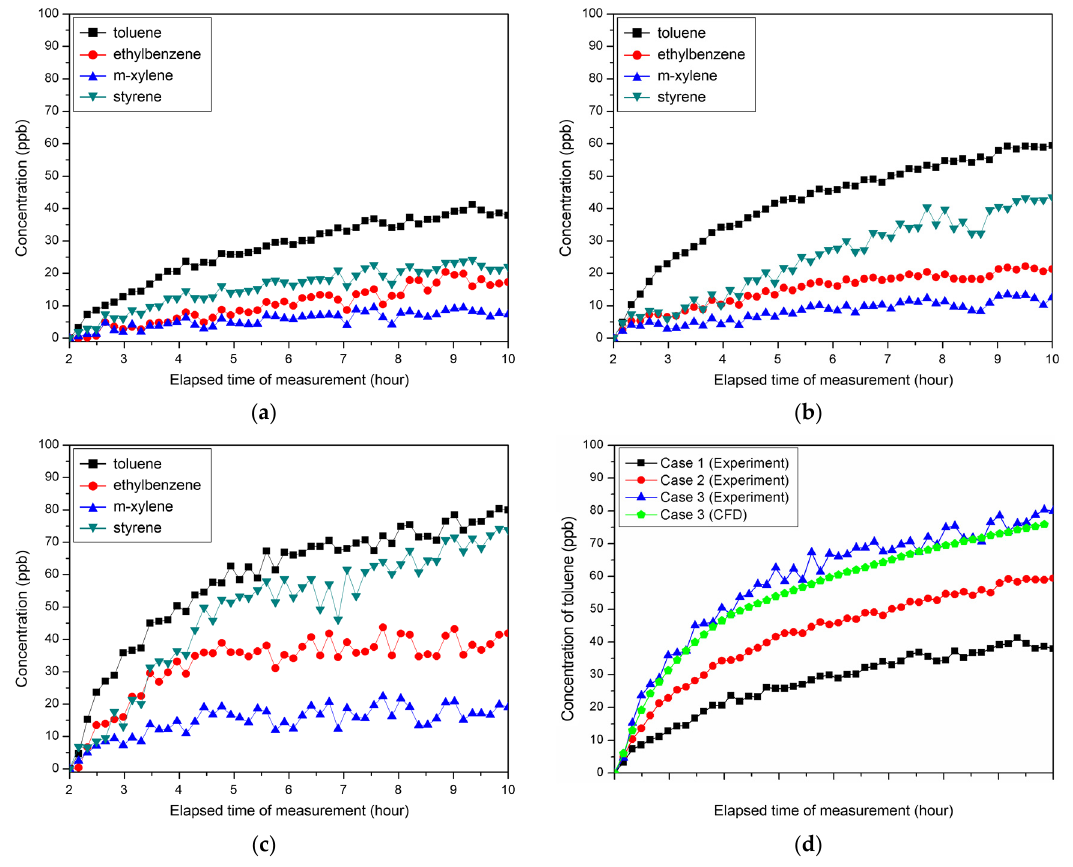
Figure 7. Concentrations of pollutants per case: ( a ) Case 1; ( b ) Case 2; ( c ) Case 3; ( d ) Toluene concentration of each case. CFD: computational fluid dynamics.